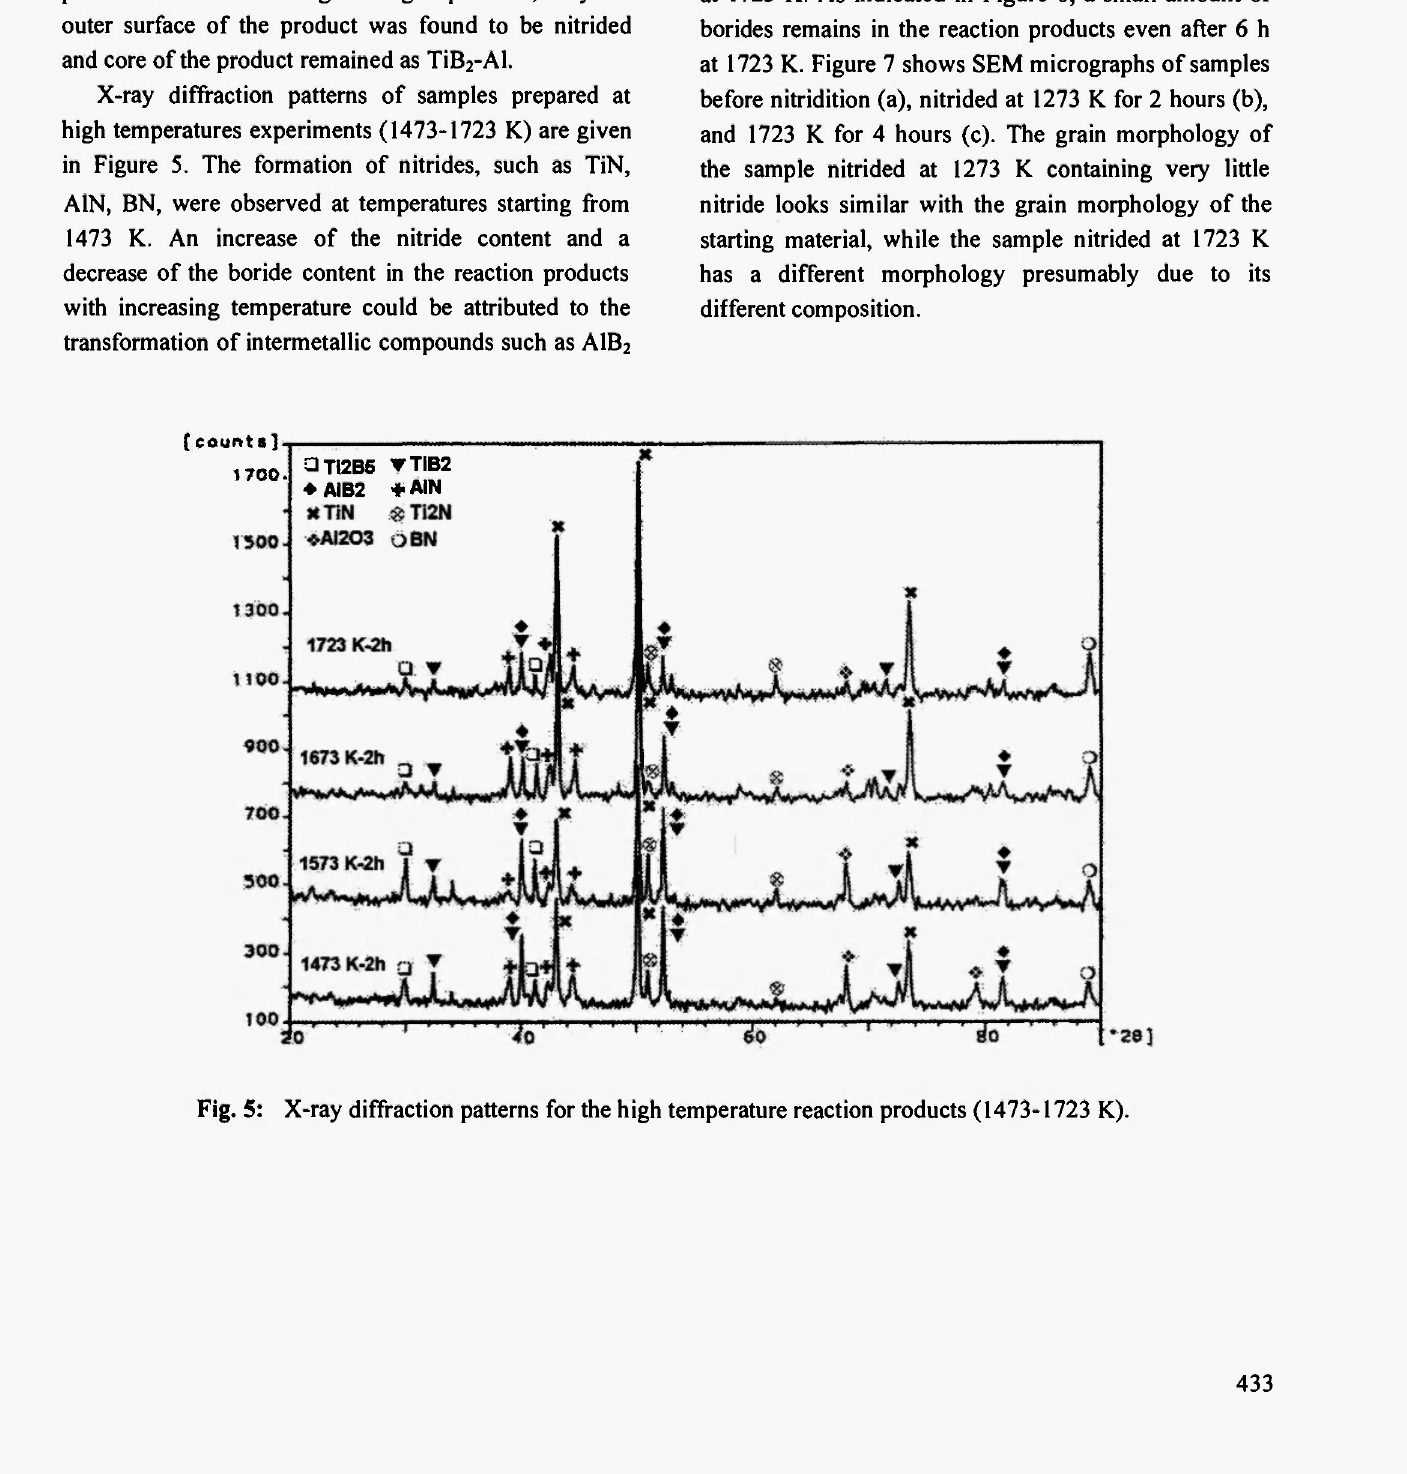
Fig. 5: X-ray diffraction patterns for the high temperature reaction products (1473-1723 K).